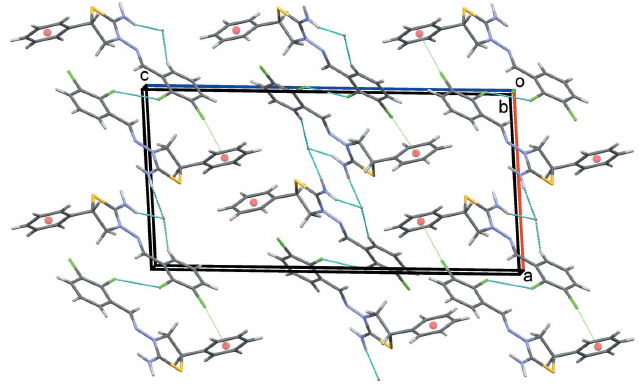
Figure 3 C—H (cid:2)(cid:2)(cid:2) Br and N—H (cid:2)(cid:2)(cid:2) Br hydrogen bonds and , 2